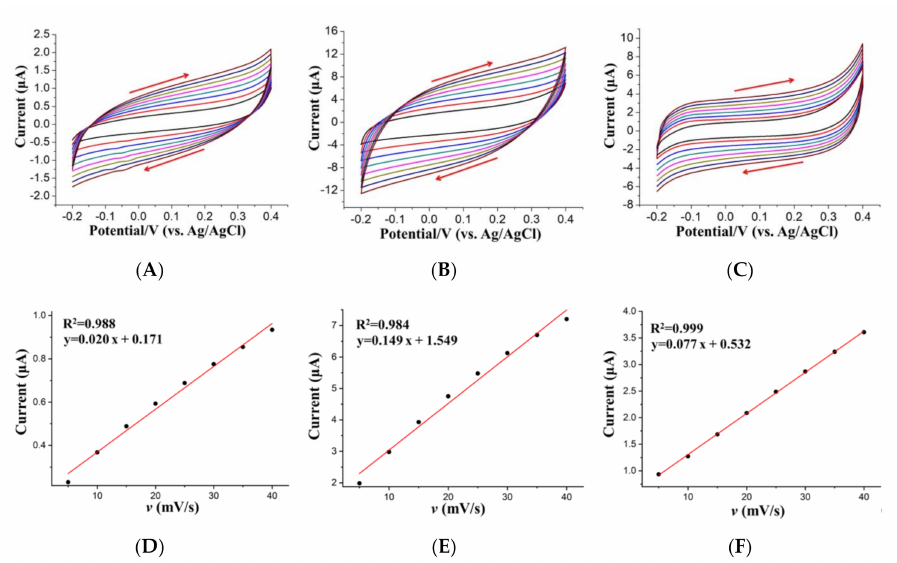
Figure 4. Cyclic voltammograms for the glassy carbon working electrode (GCE) ( A ), (BiO) 2 CO 3 -rGO / GCE ( B ), and (BiO) 2 CO 3 -rGO-Nafion / GCE ( C ), collected at di ff erent potential scanning rates (5, 10, 15, 20, 25, 30, 35 and 40 mV / s) in 1.0 M KOH, and the corresponding calibration curves of GCE ( D ), (BiO) 2 CO 3 -rGO / GCE ( E ), and (BiO) 2 CO 3 -rGO-Nafion / GCE ( F ), which are related to the charge transfer currents at the potential of 0.2 V and di ff erent potential scanning rates. The charge transfer currents − I 2 were calculated by the equation of I 1 ( I 1 and I 2 are the anodic and cathodic current density at 0.2 V, 2 respectively